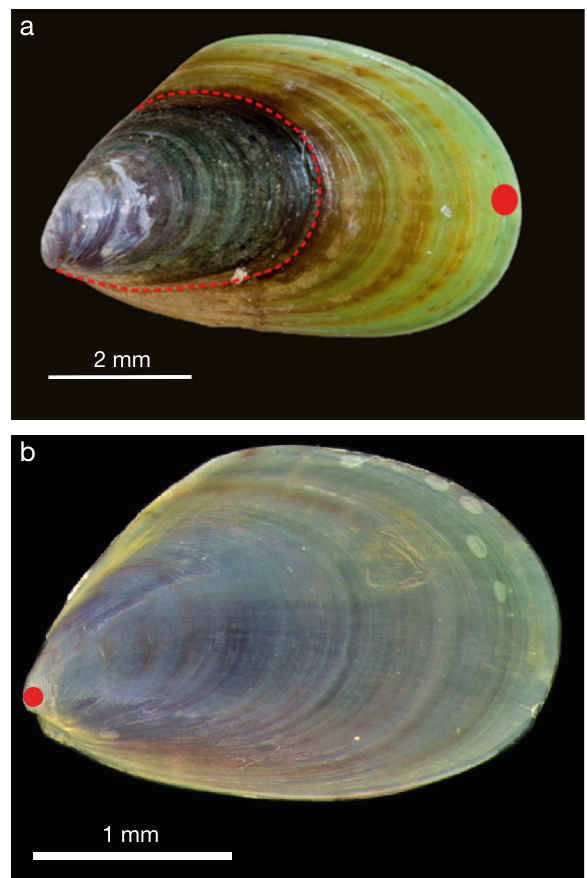
Fig. 2. Example of individual Perna canaliculus used for trace elemental fingerprinting. (a) Individual grown in an in situ culturing container to develop a reference elemen- tal fingerprint. Dashed red line: separation between shell formed prior to translocation and that deposited in situ . (b) Recently settled individual from an artificial settlement substrate. Red dots: location of LA-ICP-MS analysis on each